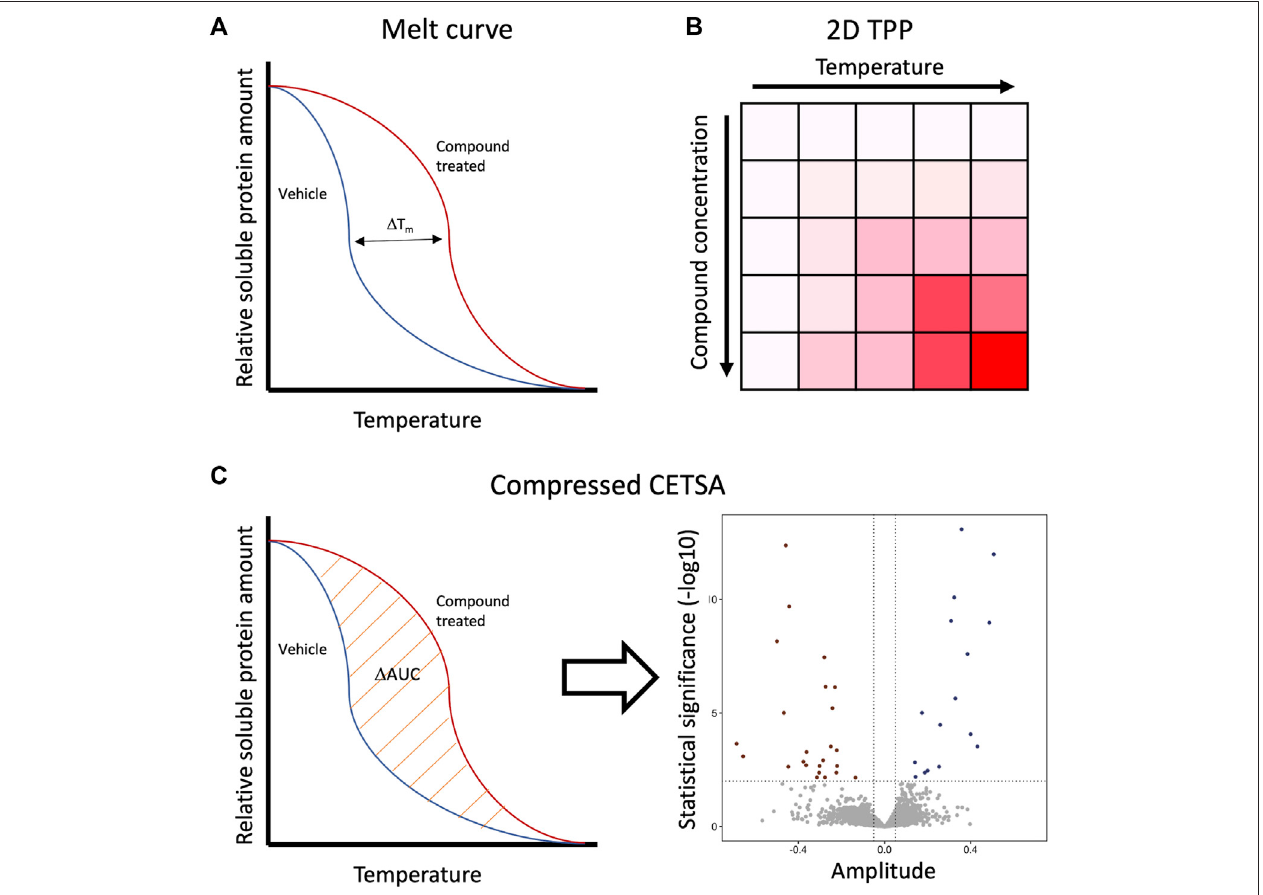
FIGURE 2 | Ways to represent the data from different CETSA formats. (A) Melt curve represents the soluble protein amount as a function of temperature. Thermal shift magnitude is represented as Δ T m . (B) 2D TPP results are usually represented as a two-dimensional matrix, where the color intensity re fl ects the magnitude of Δ T m . Each temperature and compound concentration are plotted separately. (C) In compressed CETSA, protein average abundancy is measured, which is basically melt curves of AUC. These AUCs of the vehicle and compound treated samples are compared to each other and represented in a volcano plot as amplitude.